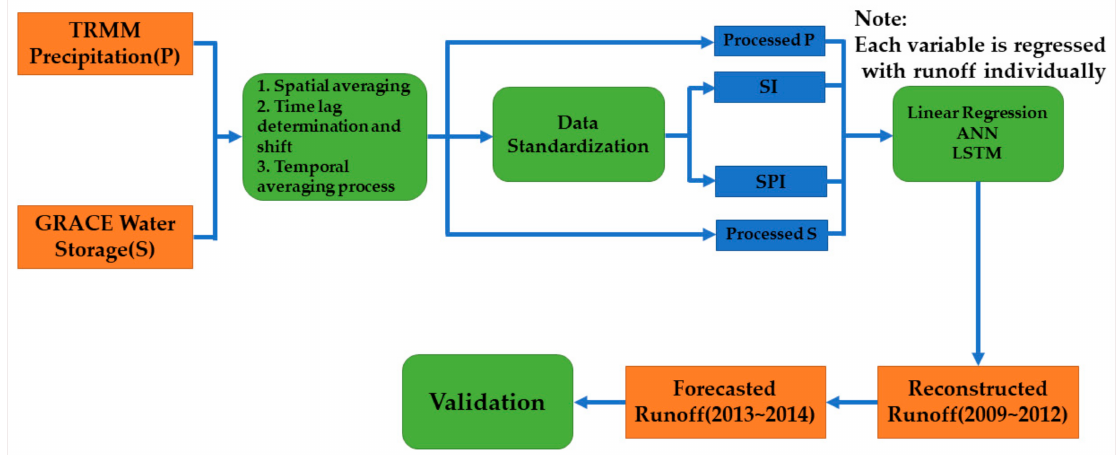
Figure 4. The methodology